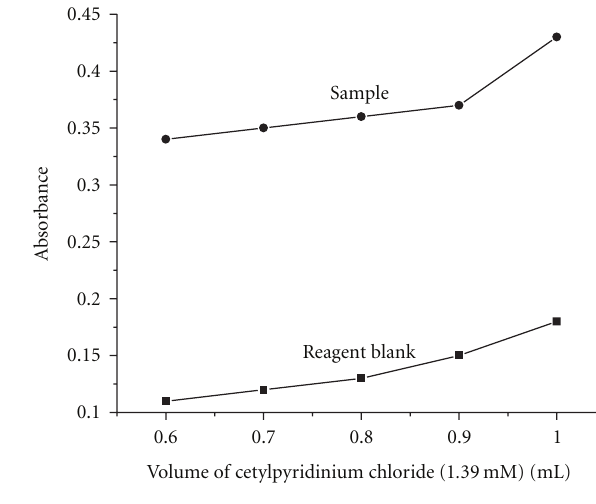
Figure 6: E ff ect of cetylpyridinium chloride.